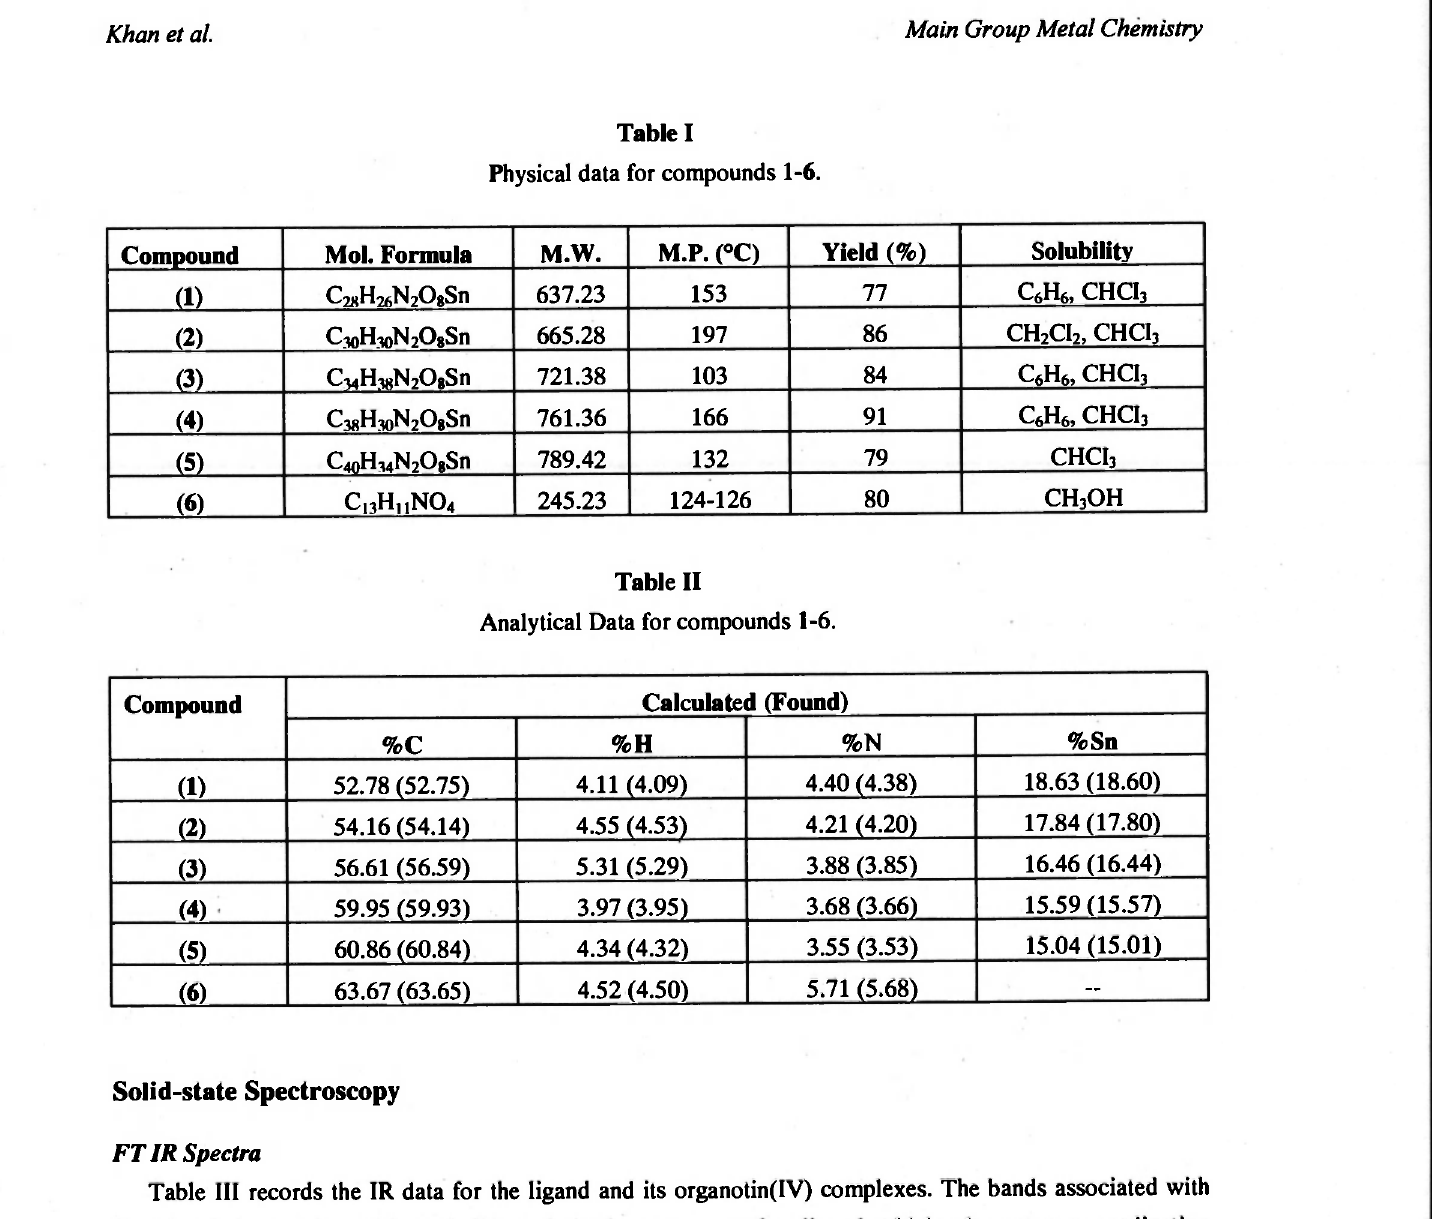
Physical data for compounds 1-6.